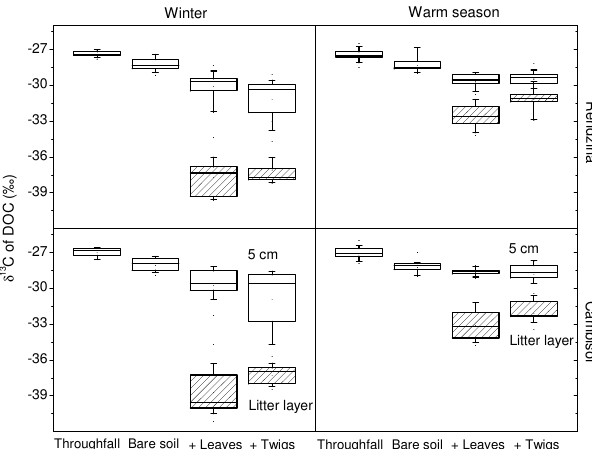
Fig. 6. Variability in the δ 13 C of the DOC leached from both the litter layer and the mineral soil at a depth of 5cm as well as the δ 13 C of throughfall DOC. Each box shows the median value, the quartiles and the 2.5%- and 97.5%-quantiles of 15 single measurements in the winter (Nov 07–Apr 08) and in the warm season (Apr 08–Nov 08).